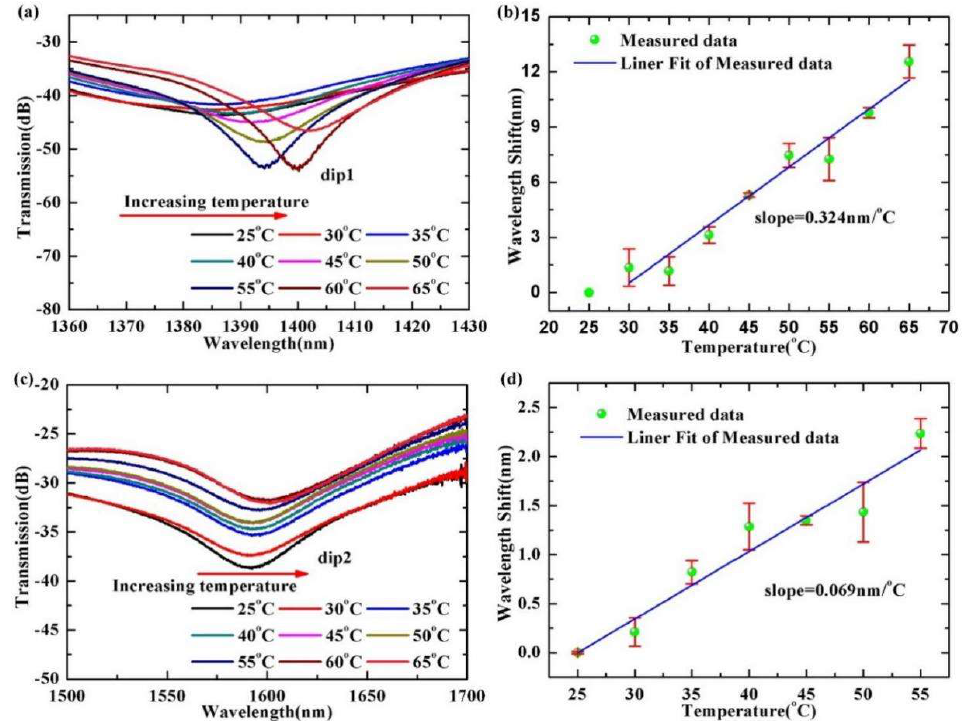
Figure 6. ( a , c ) Wavelength shifts of the dip1 and the dip2 of the interference spectra with the temperature. ( b , d ) The wavelength shift trends of the dip1 and the dip2 of the interference spectra with temperature.